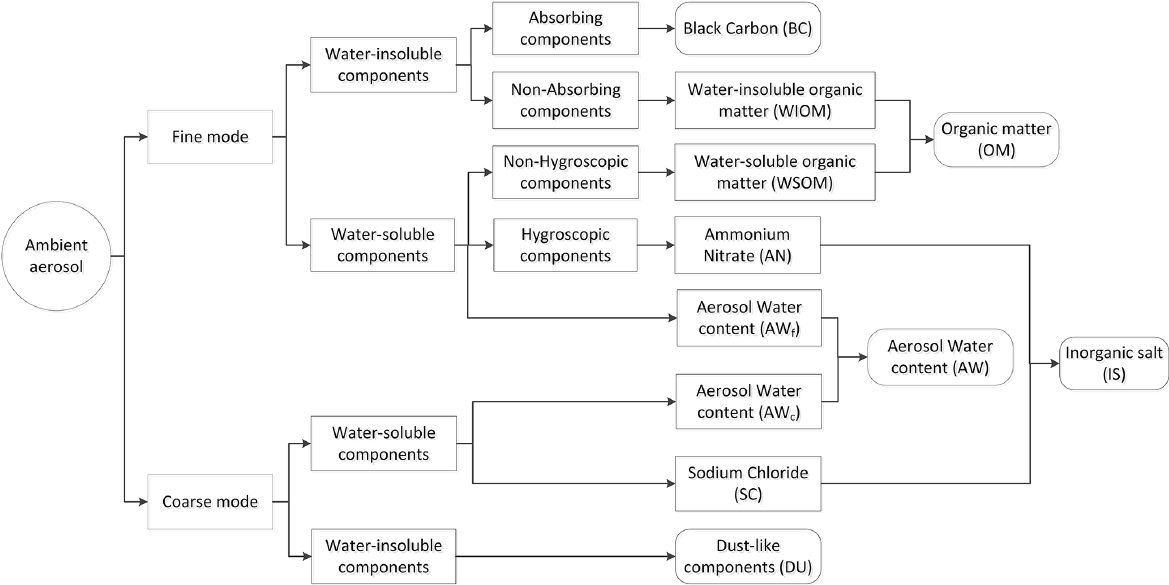
Figure 3. Aerosol component classification